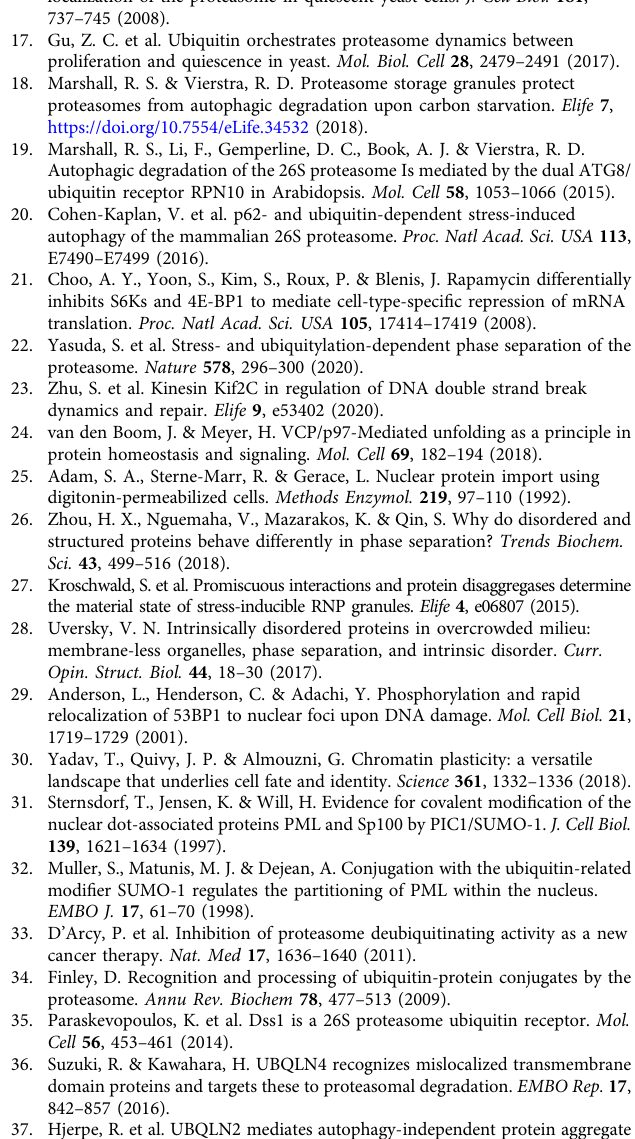
Fig. 10 Inhibition of SIPAN formation is associated with apoptosis. a Proteasome is active under nutrient starvation. IMR90 cells were incubated in HBSS for 8 hrs and then treated with MG132 for 1 hr and harvested for immunoblotting (representative from 3 independent experiments). b SIPAN are catalytic active. IMR90 cells were treated with HBSS for 6 hrs and then incubated with 1 µ M of Me4Bodipy-Ahx3-L3-VS proteasomal activity probe for 1 hr. Cells were then harvested for immunostaining (representative from 3 independent experiments). c – e Inhibition of RAD23B or PSME3 result in increased cell survival following nutrient deprivation. Three days following siRNA transfection, IMR90 cells were incubated in HBSS for 48 hrs and harvested for MTT viability assay ( c ), Western blotting ( d ), phase contrast imaging or FACS analysis ( e ) ( n = 2 independent experiments). Red arrow in ( e ) represents subG1 apoptotic cell population. f Induction of pro-apoptotic factors during HBSS treatment. IMR90 cells were treated with HBSS and harvested at the indicated times for western blotting (representative from 3 independent experiments). g Depletion of RAD23B or PSME3 cells protects from cell death induced by nutrient starvation. IMR90 cells without RAD23B or PSME3 were treated with HBSS for 48 hrs and harvested for immunoblotting for pro-apoptotic proteins (representative from 3 independent experiments). h – j Depletion of NOXA protects from cell death induced by nutrient deprivation. IMR90 were depleted of NOXA and treated with HBSS for 48 hrs and harvested for western blotting ( h ), MTT assay ( i ) and phase contrast ( j ) (representative from 3 independent experiments). k Schematic representation of the procedure for the generation of IMR90 cells transformed or derived from tumors. l Primary, transformed or tumoral IMR90 cells were treated with HBSS for 8 hrs and harvested for immunostaining for PSMD4 (representative from 3 independent experiments). m , n Cells were treated with HBSS for 96 hrs and stained with Hoechst (DNA) and propidium iodide for imaging ( m ) and counting of